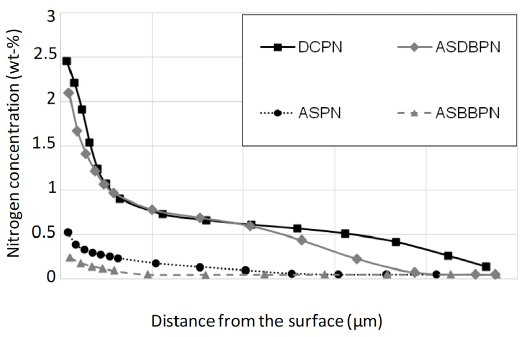
Figure 5. Nitrogen concentration profile for the nitrided specimens.